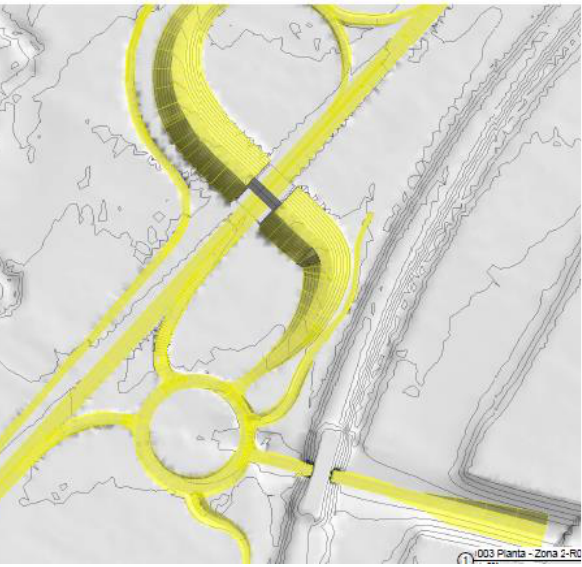
Figure 5. BIM model of the risk of falling to different levels during the execution of the earthworks work unit with the conventional risk assessment.